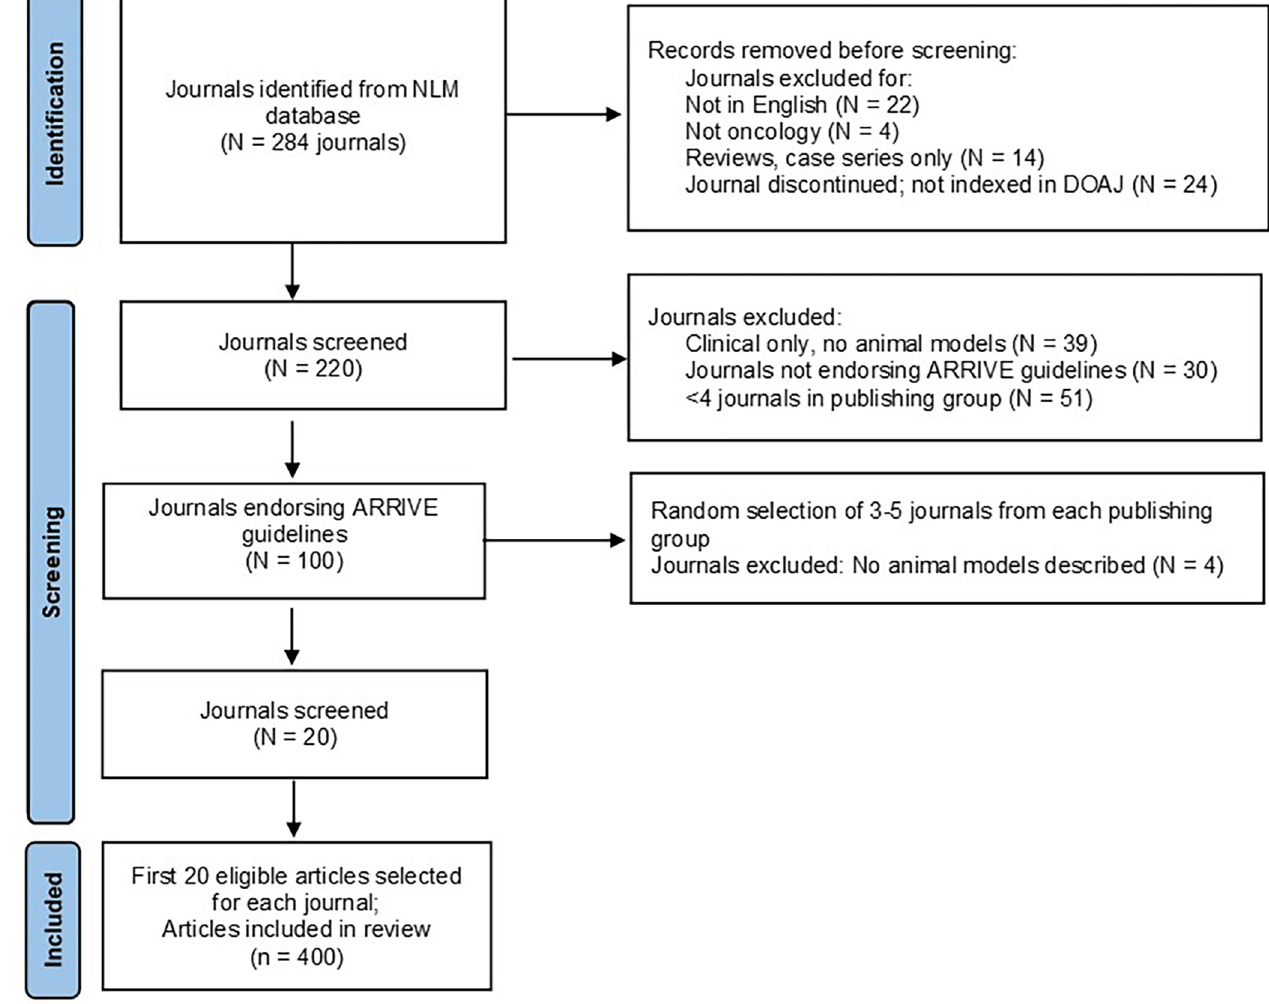
PLOS ONE | https://doi.org/10.1371/journal.pone.0274738 October 20,